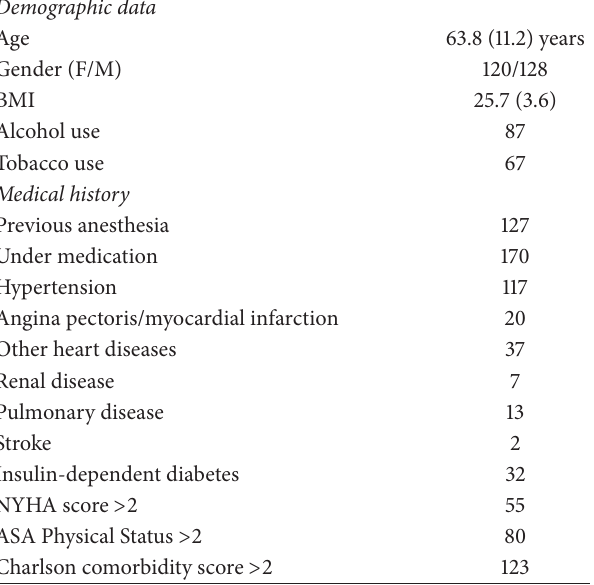
Table 1: Demographic and clinical characteristics.